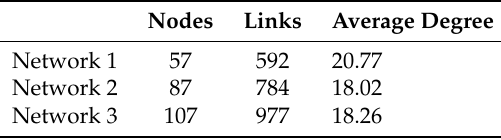
Table 1. Characteristics of three